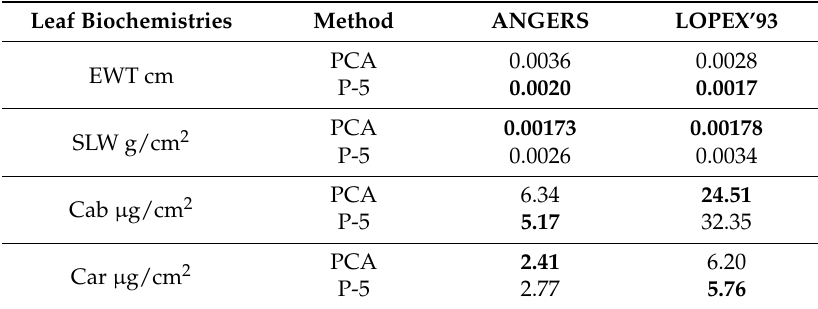
Table 8. Comparison of estimates of leaf biochemical contents made using the principal component analysis (PCA) method and the P-5 method. (P-5 represents the PROSPECT-5 model inversion method used by F é ret et al. [71]).